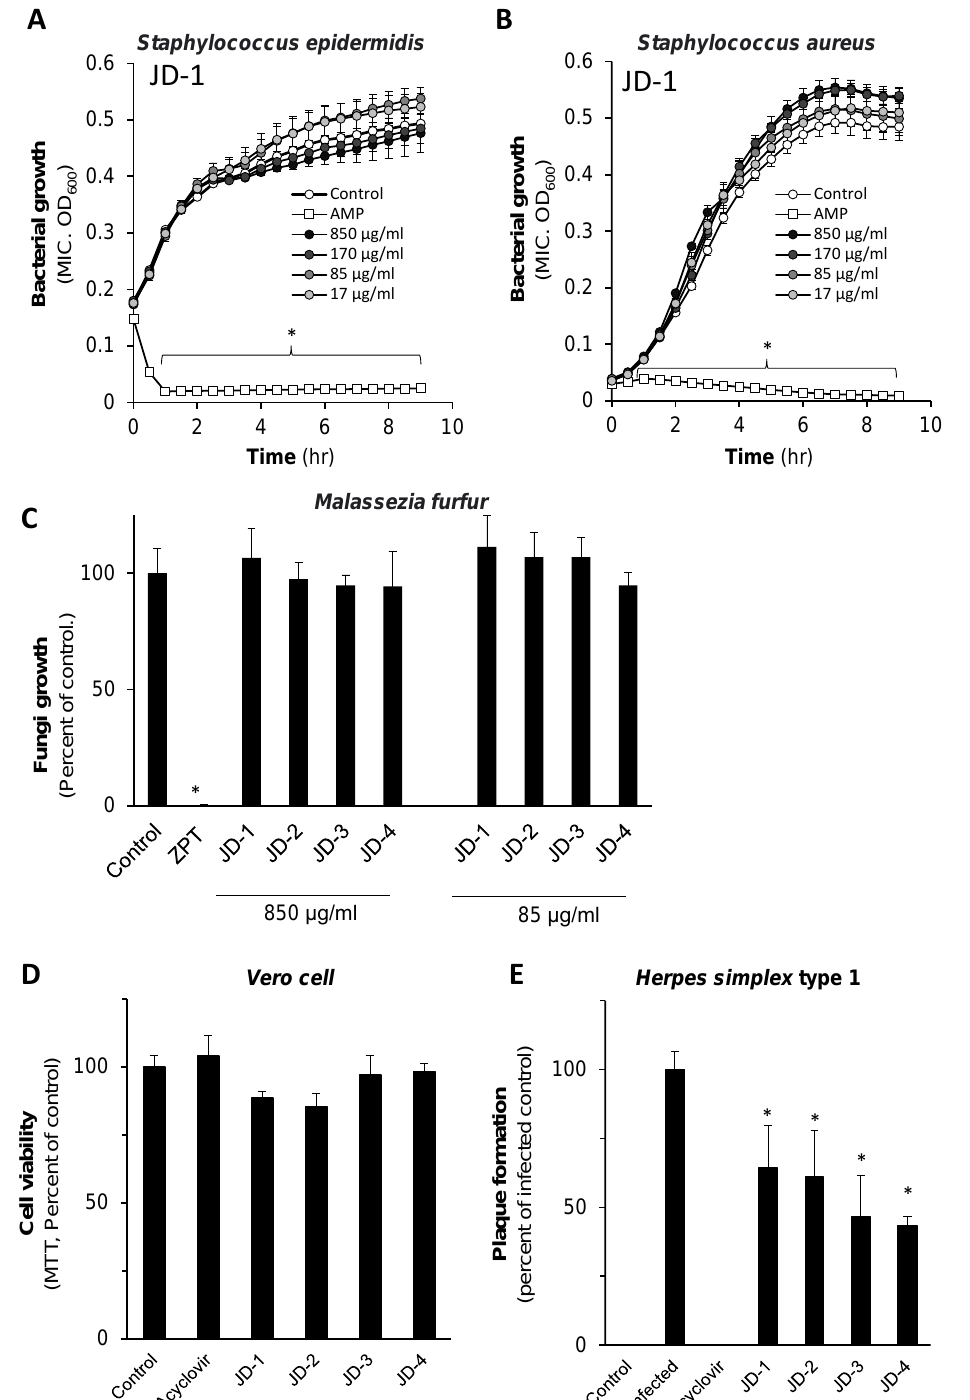
Figure 1. The impact of Jojoba wax on bacterial, fungal, and viral growth. Jojoba wax was added to S. epidermidis ( A ), and S. aureus ( B ) at the indicated concentrations, and their growth was monitored kinetically with or without the wax supplementation. AMP-ampicillin was used as the positive control (10 µg/mL). The results of representative Jojoba wax (JD-1) are presented. M. furfur ( C ) cultures were supplemented with either low (85 µg/mL) or high (850 µg/mL) wax, and fungi growth was assessed by fluorescence of AlamarBlue after 24 hr. ZPT- Zinc pyrithione (100 µg/mL) was used as antifungal positive control. Mean ± standard error of the mean (SEM); n = 3; * p < 0.05 in comparison to the naïve control. ( D ) and ( E ) present the impact of 850 µg/mL on Vero cell viability or its impact on HSV-1 plaque formation as mentioned in the “materials and methods” section. Mean ± SEM; n = 3; * -significant differences, p < 0.05 in comparison to the infected control. Acyclovir was used as an antiviral positive control.